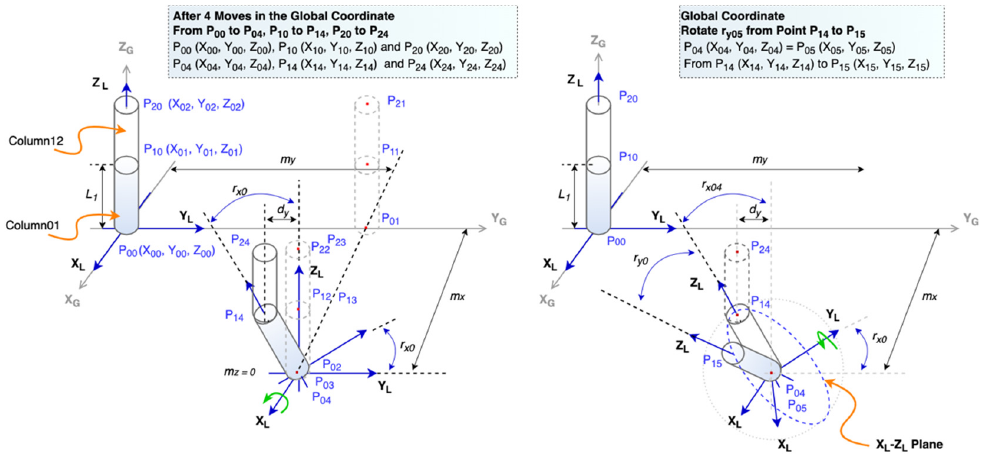
Figure 4. Movements caused by X-Y